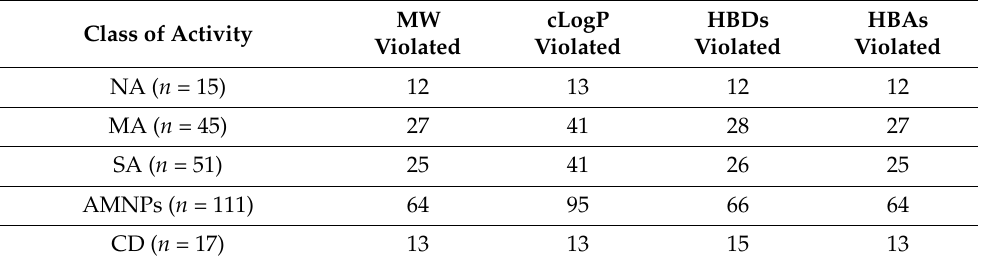
Table 1. The proportion of compounds that adhered to Lipinski’s rule when ≤ 1 of the parameters was